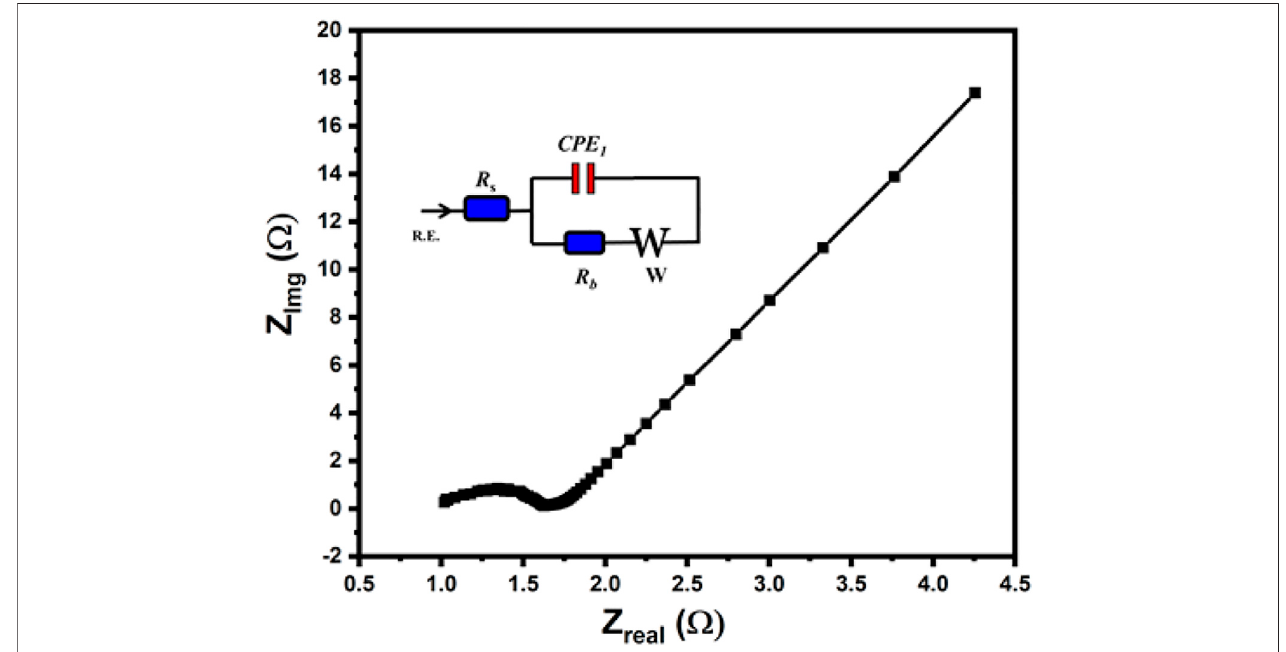
FIGURE 14 | Nyquist plot for c-4CzPN – KOH recorded in 6.0 M KOH. The circuit used for fi tting the EIS results is shown in the inset.